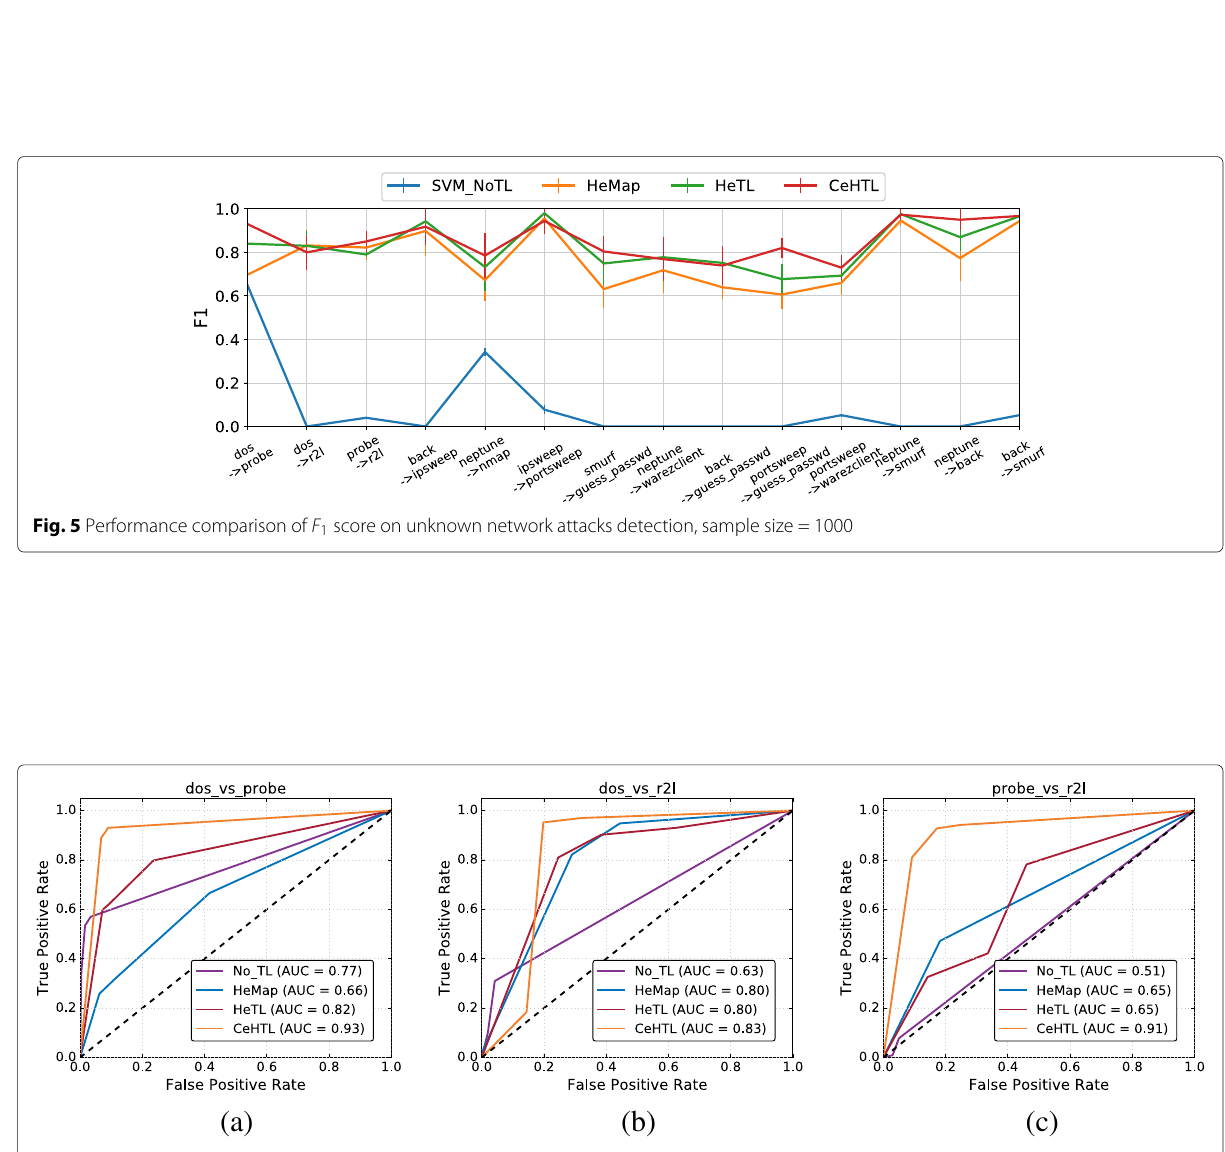
Fig. 6 Performance comparison of ROC curves on the three transfer learning datasets. a ROC curve on DoS → Probe. b ROC curve on DoS → R2L c . ROC curve on Probe →